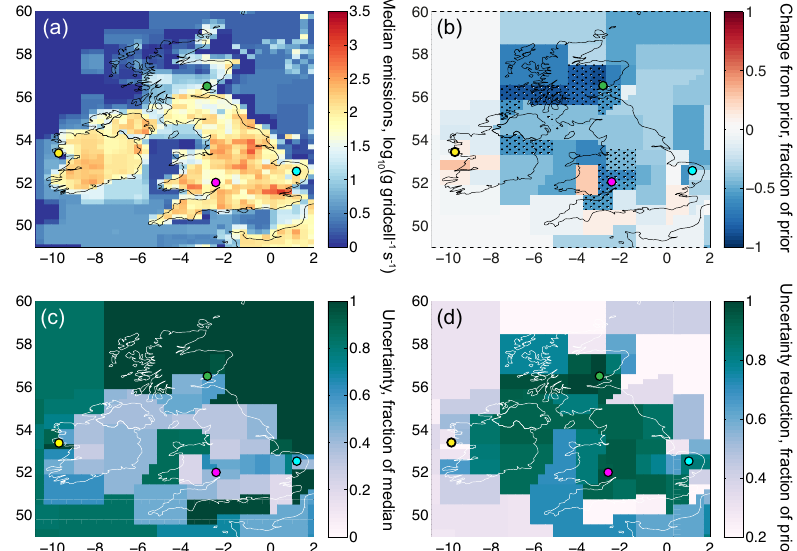
Figure 4. (a) Median posterior CH 4 emissions shown on a logarithmic scale. Emissions have been disaggregated from the larger regions estimated in the inversion using the prior distribution. (b) Difference between the median posterior emissions and the prior, relative to the prior. Dots show statistically significant differences, where the prior emissions lie outside of the 5th to 95th percentile range of the posterior emissions. (c) Posterior emissions uncertainty. This corresponds to the average difference between the median and the 5th and 95th percentiles, relative to the median. (d) Uncertainty reduction from the prior, relative to the prior. Colored circles show the measurement stations (MHD, yellow; RGL, magenta; TAC, cyan; TTA,